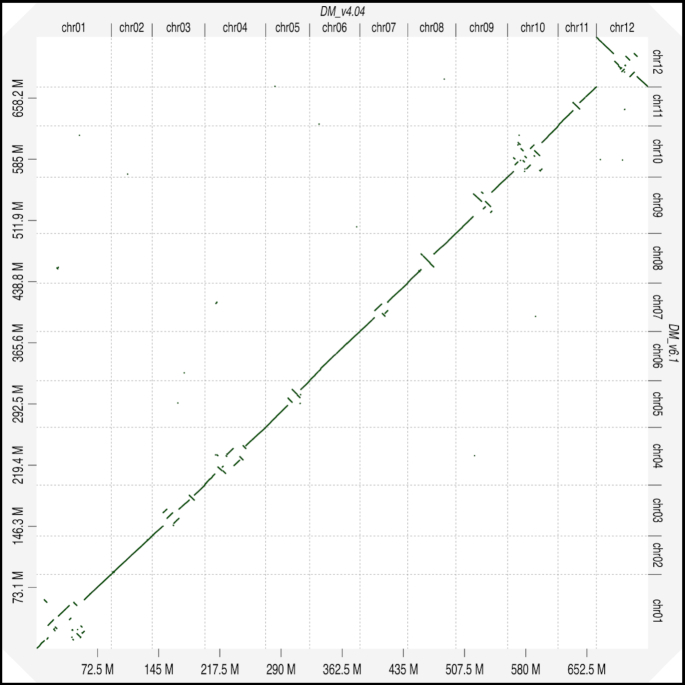
Whole-genome alignment of the DM v4.04 vs v6.1 DM genome assemblies. Whole-genome alignments of the long-read, chromosome-scale DM v6.1 assembly with the DM 4.04 genome assembly using D-GENIES reveals concordance in the euchromatic arms but misassemblies in the pericentromeric regions.